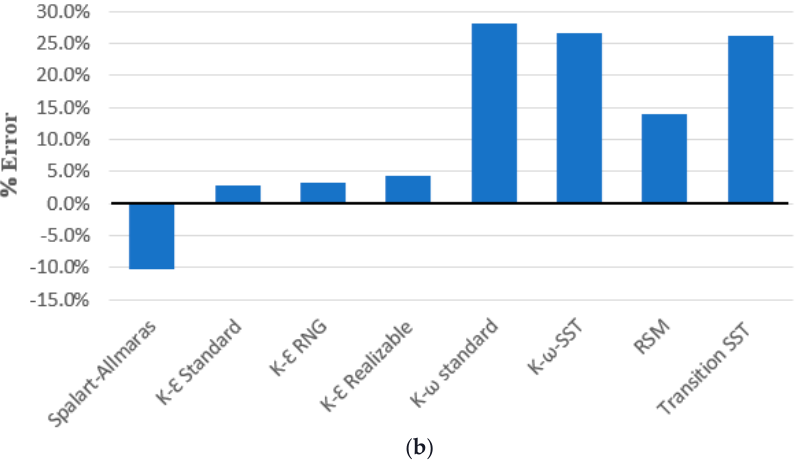
Figure 10. Predicted rotor’s angular speed based on different turbulence models. ( a ) maximum angular speed, ( b ) percentage error in the maximum angular speed.